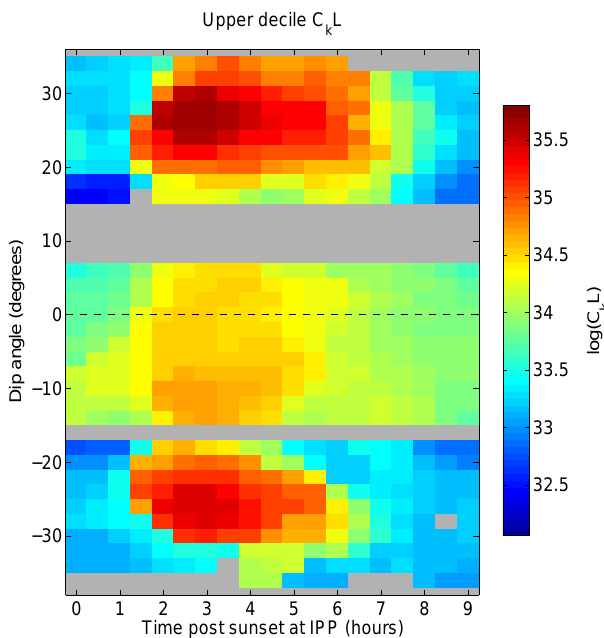
Fig. 12. Upper decile C k L combined from three sites during September 2000. Dashed line indicates magnetic equator. A 30 ◦ elevation mask was applied to the raw